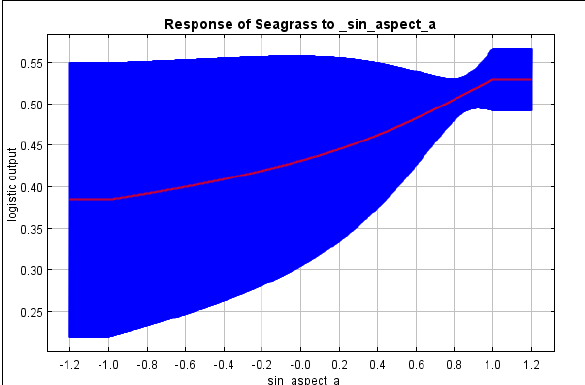
Figure 12. Response curves of sine of aspect for the seagrass habitat suitability